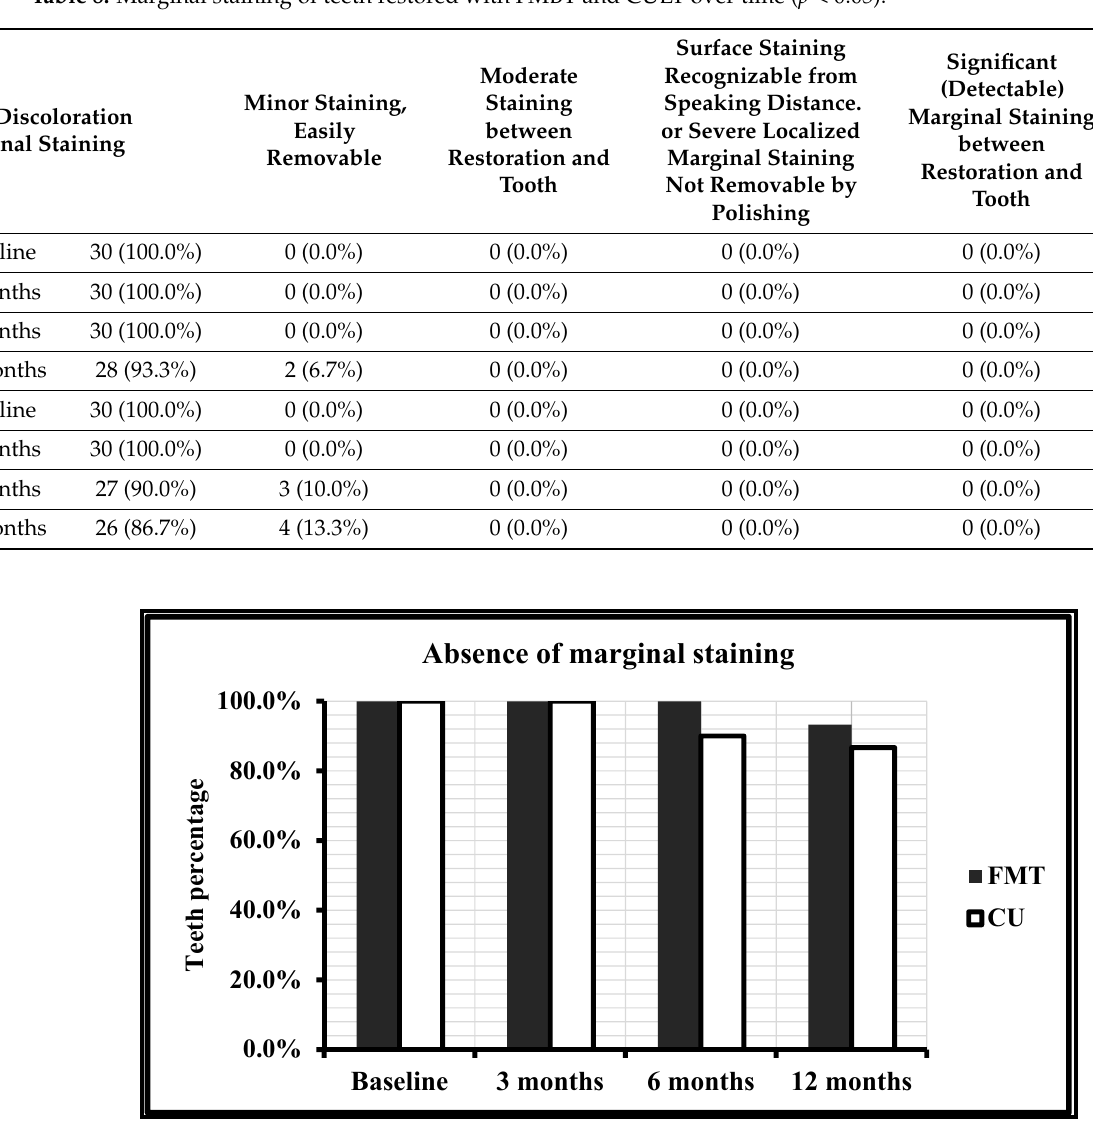
Figure 8. Absence of marginal staining with FMBT and CULT over time.